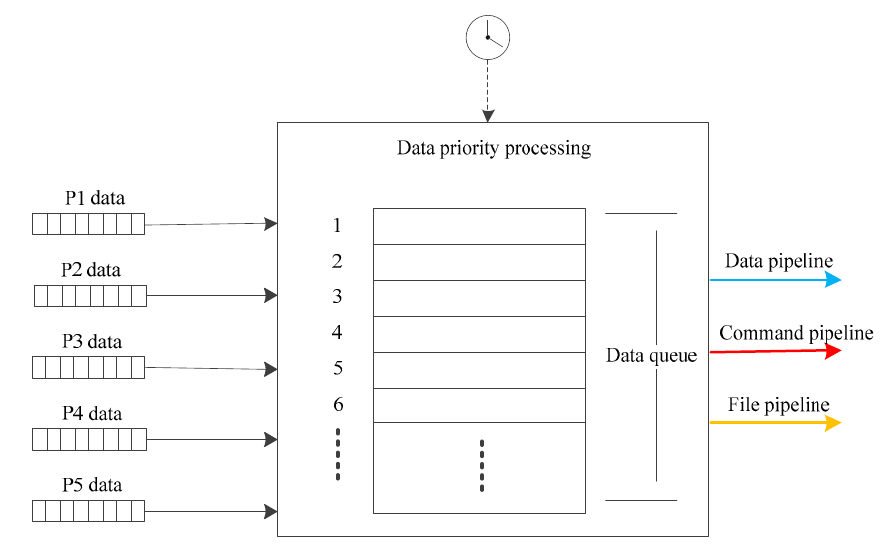
Figure 8. Data priority processing.